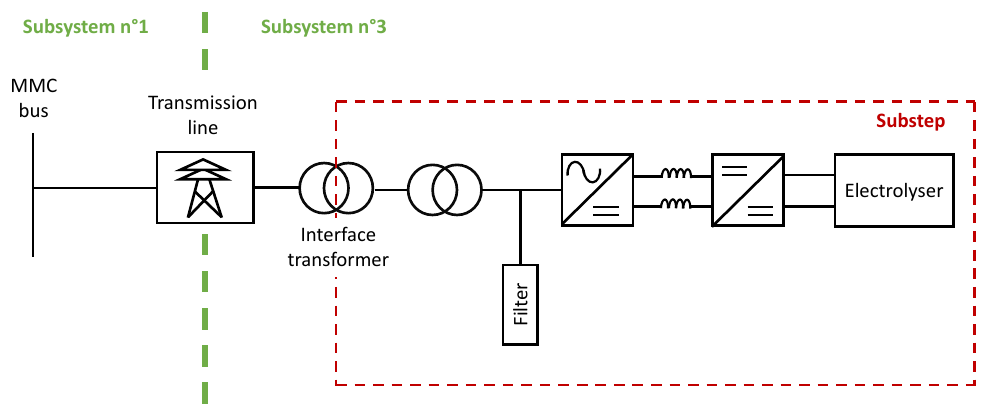
Figure 9. Electrolyser system model in Scenario 2. The division into subsystems (green vertical line) is explained in Figure